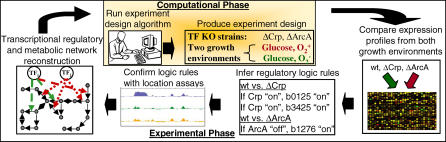
An Overview of the Combined Computational and Experimental Iterative ProcedureThe computational algorithm utilizes a dynamic simulation of the current integrated transcriptional regulatory and metabolic network reconstruction to design experiments. The new regulatory logic rules discovered by the experiments are then added to the reconstruction.TFi, transcription factor i; TFj, transcription factor j.